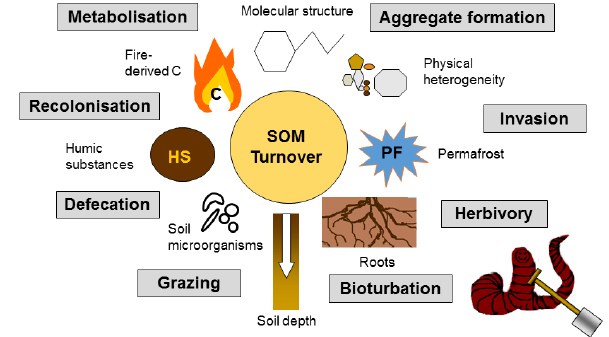
Figure 1. Main animal-mediated processes (boxes) affecting the eight insights (symbols) identified by Schmidt et al. (2011) that should be considered for improving SOM